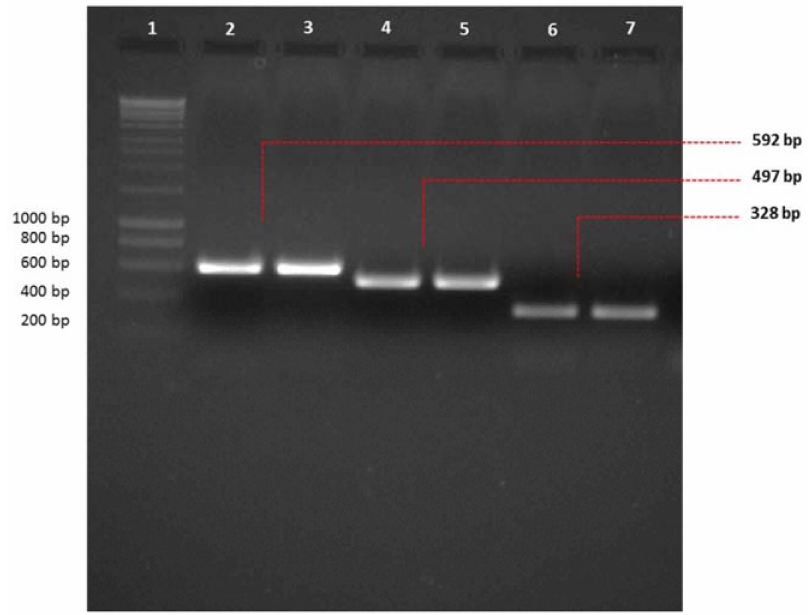
Figure 1. Conventional PCR to check amplicon size prior to multiplex PCR. Amplicon sizes